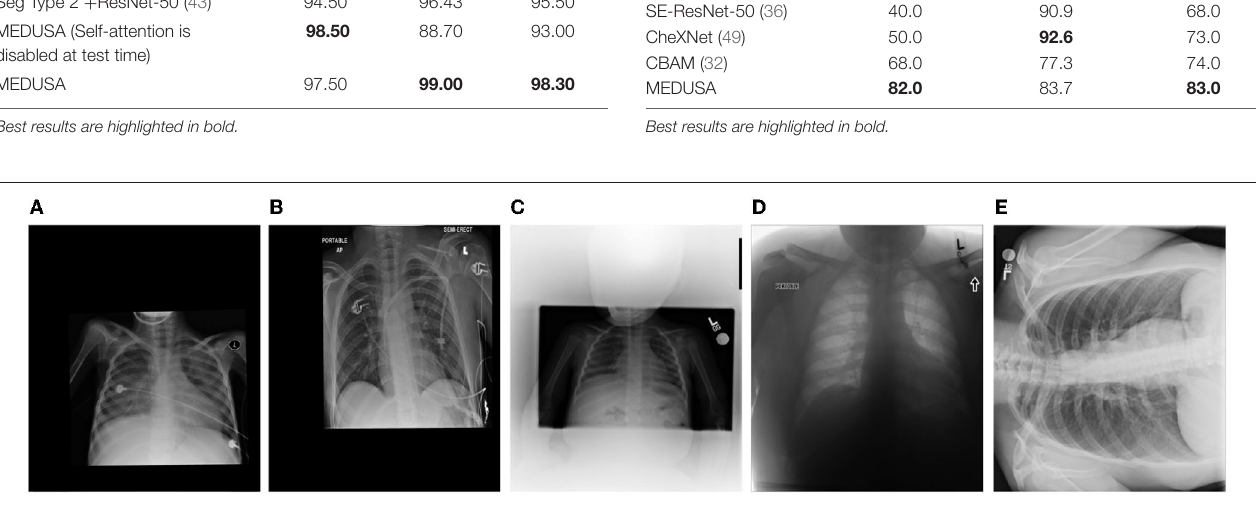
Frontiers in Medicine |